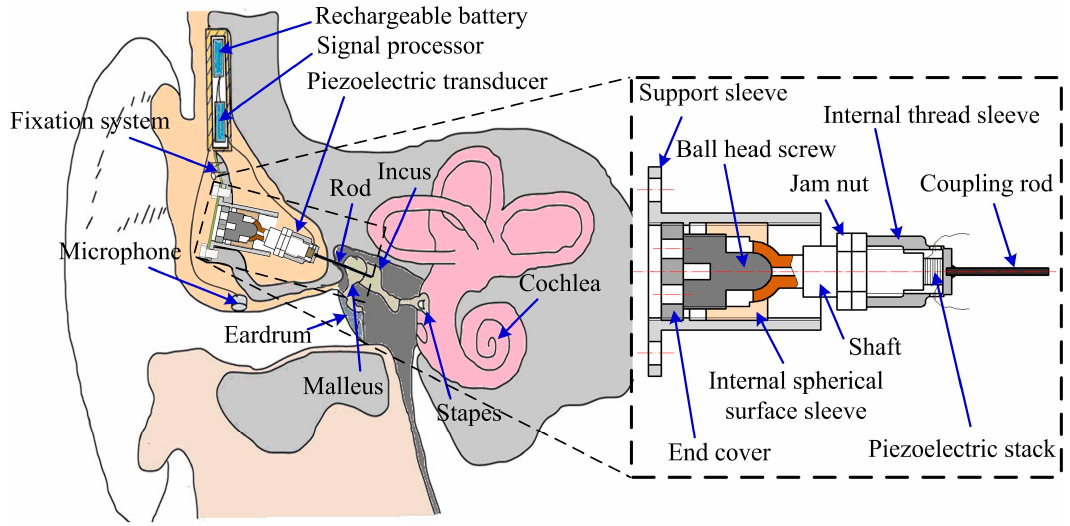
Figure 1. Illustration of the proposed implantable middle ear hearing device and its piezoelectric